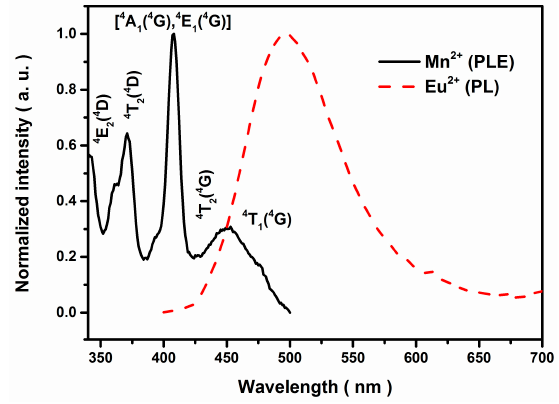
Figure 3. Photoluminescence (PL) and photoluminescence excitation (PLE) spectra of CGP:0.006Eu 2+ (dash line) and CGP:0.02Mn 2+ (solid line).